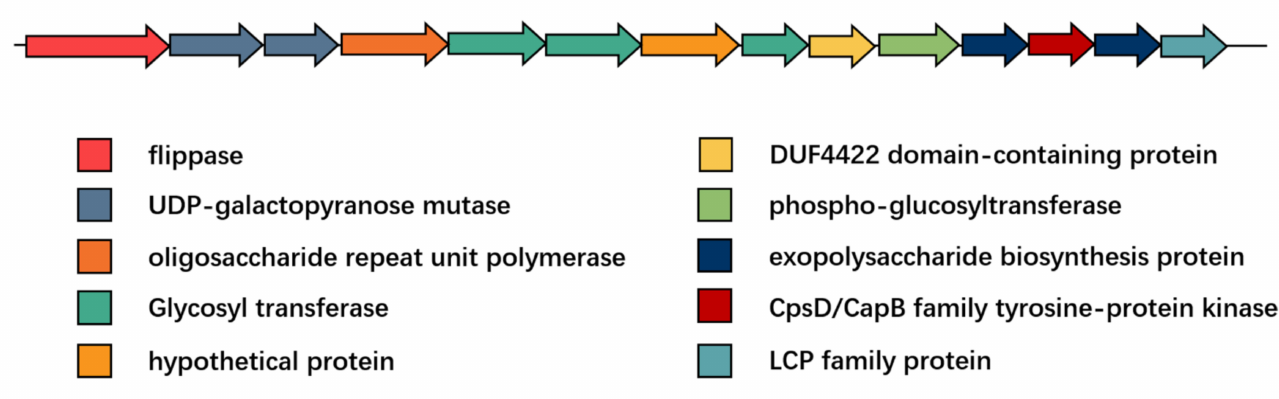
Figure 9. EPS gene cluster in L. acidophilus NCFM .